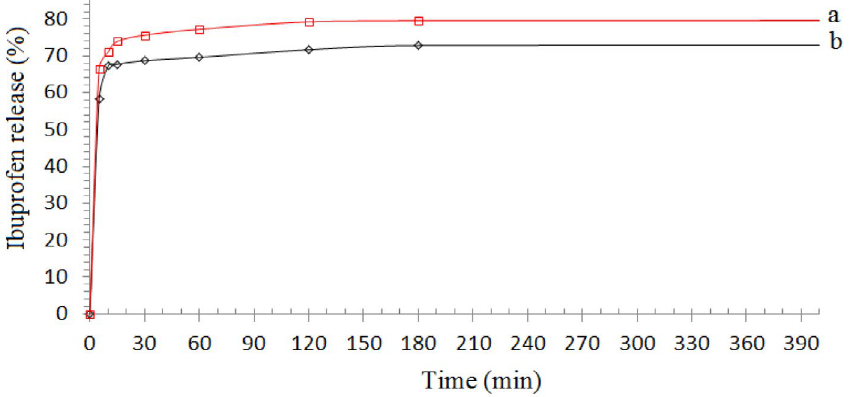
Fig. 6. Release profiles for 25 and 50% ibuprofen supported γ-alumina in SIF (a) γ-Al-IBU25 and (b) γ-Al-IBU50